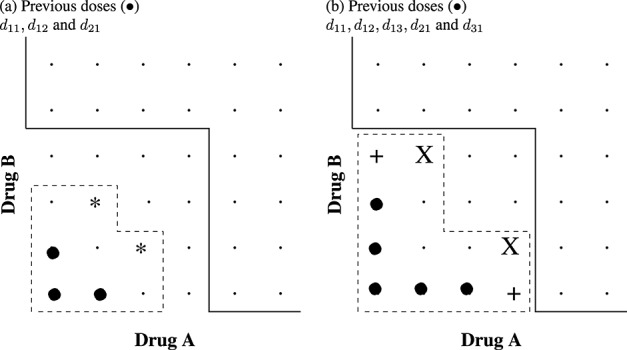
The set of admissible doses that are closest and adjacent (X), adjacent but not closest (+) and largest (*) to C*(m) under non-neighbourhood dose-skipping constraint. The solid line shows C*(m). The dashed line shows the current dose-skipping constraint (i.e. only dose combinations within the dashed box are admissible).